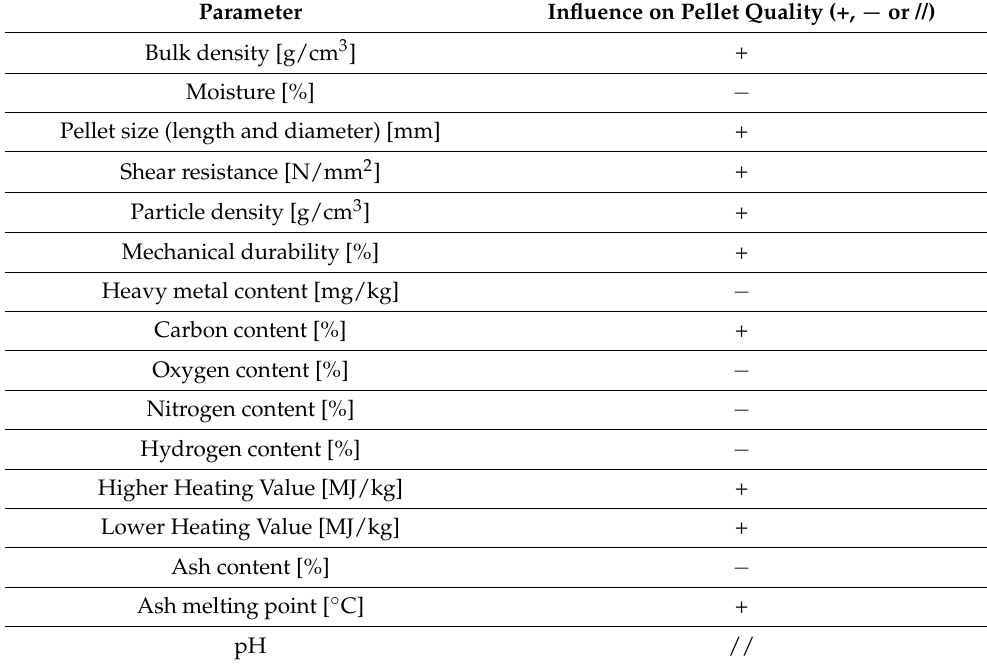
Table 2. List of investigated parameters and influence of single parameter on pellet